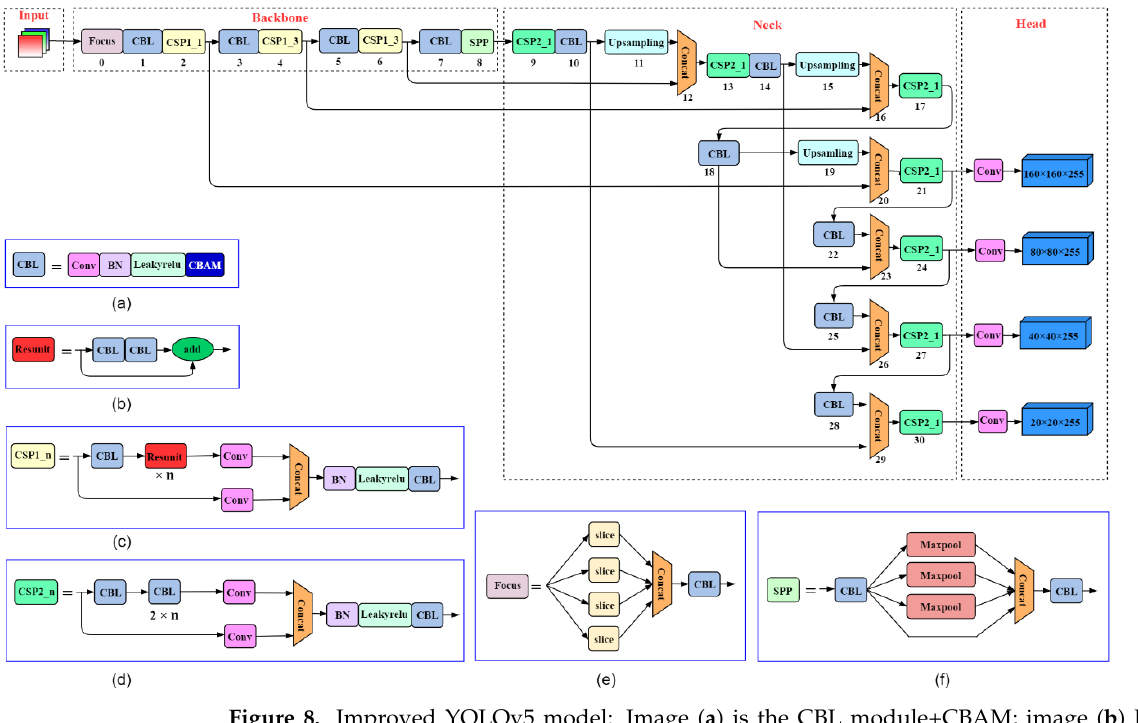
Table 1. Improved YOLOv5s model compared to YOLOv5s, YOLOv5+CBAM, and YOLOv5s+de- tect.